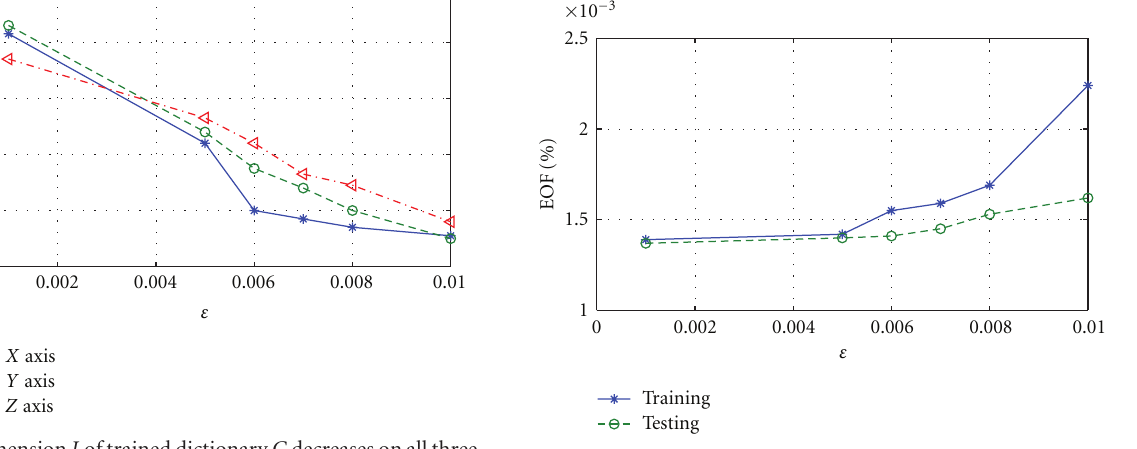
Figure 10: EOF of gallbladder reconstruction increases as ε gets larger for both training and testing